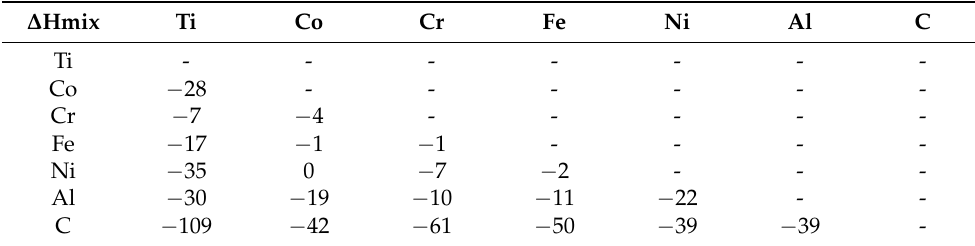
Table 1. The mixing enthalpy ( ∆ H mix , KJ · mol − 1 ) for each pair of elements adapted from [44]. ∆